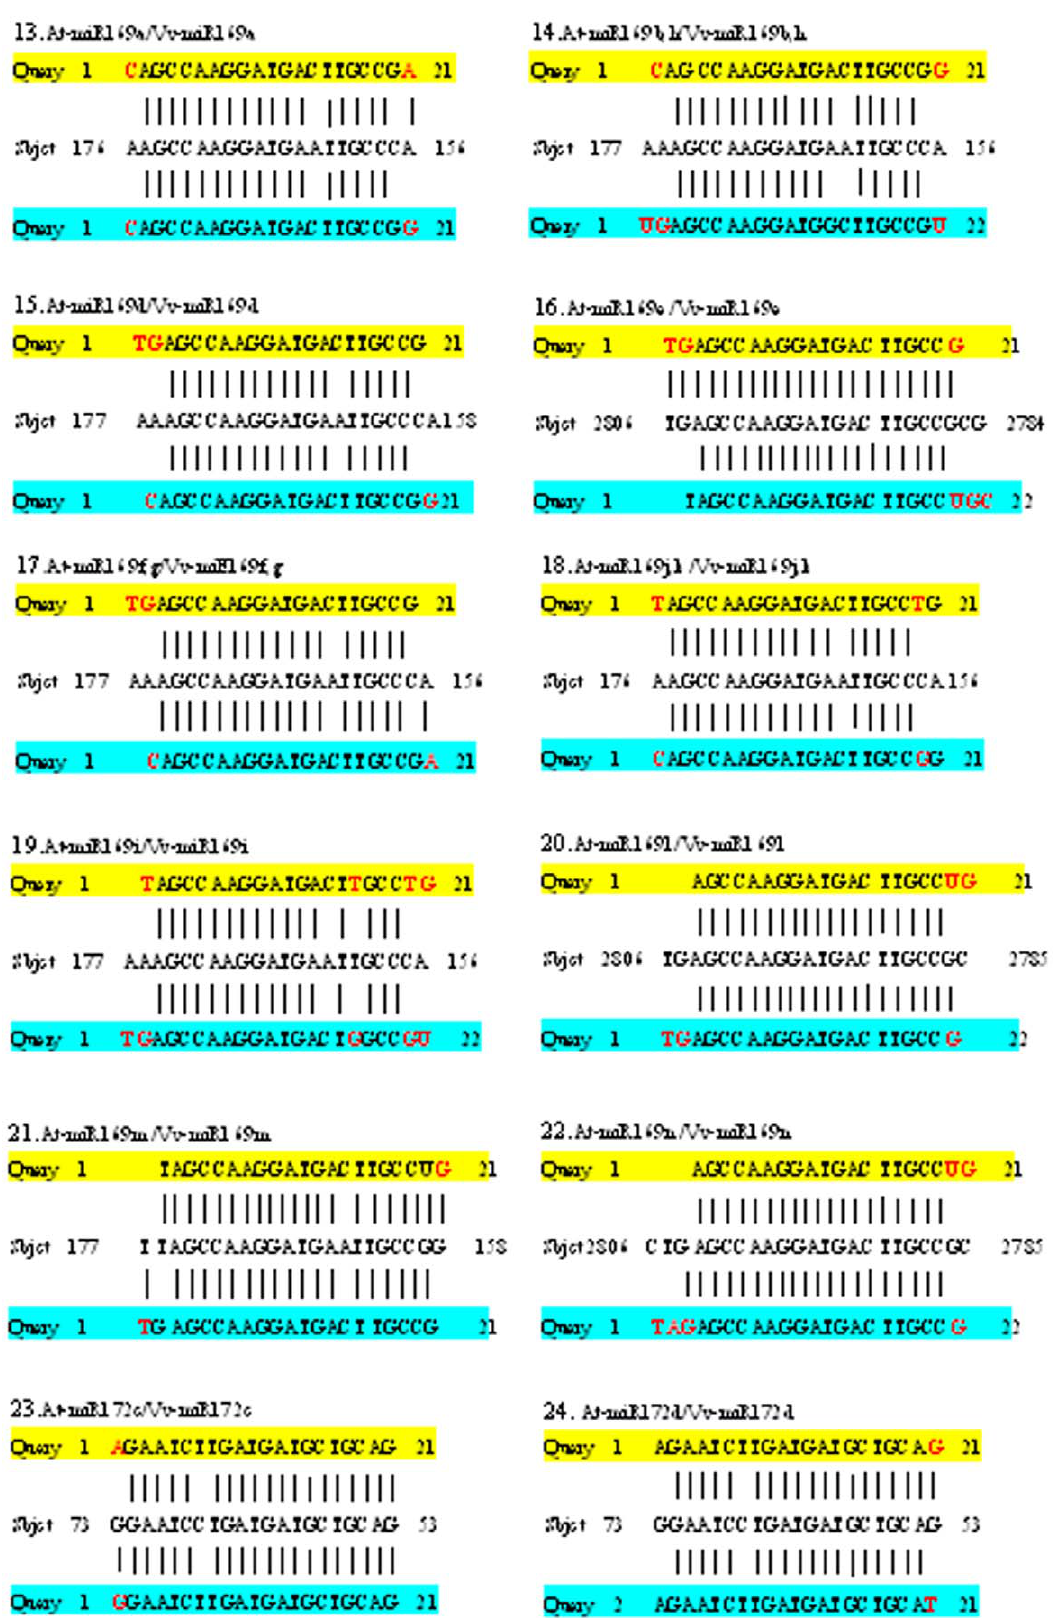
Figure 3. Comparison of the uncomplementary bases of orthologous miRNAs from Arabidopsis and grapevine with the same target sequence (continued). The yellow regions are Arabidopsis miRNAs sequences, the blue regions are grapevine miRNAs, and the middle sequences are the complementary sequences on target genes of grapevine. doi:10.1371/journal.pone.0021259.g003 PLoS ONE |